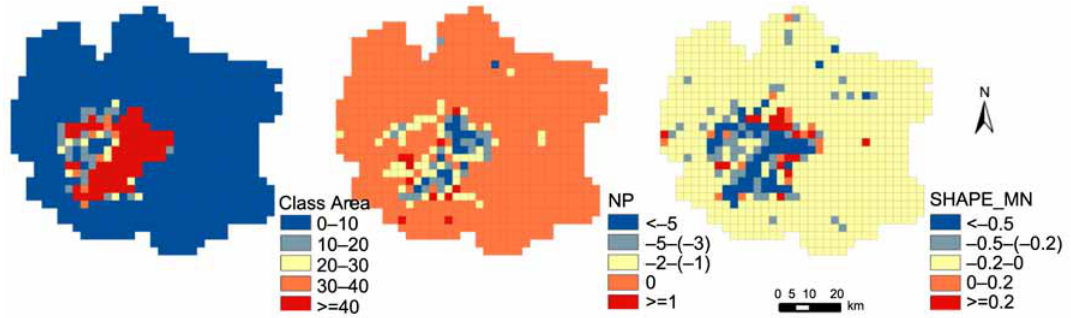
Fig. 14. Binary comparison between CDS scenario and observed landscape pattern 2010 in Class Area, NP, and SHAPE_MN